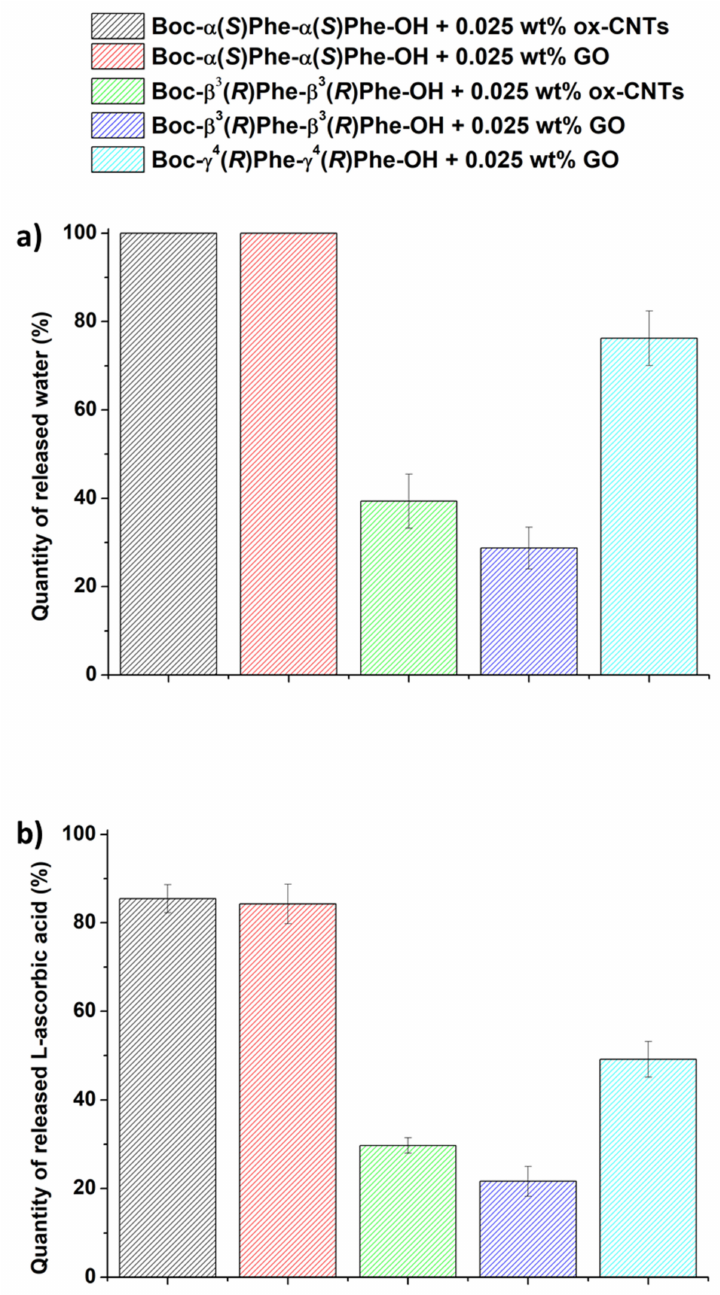
Figure 8. Release of ( a ) water (n = 3) and ( b ) L -ascorbic acid (n = 3) from the hybrid gels under NIR light